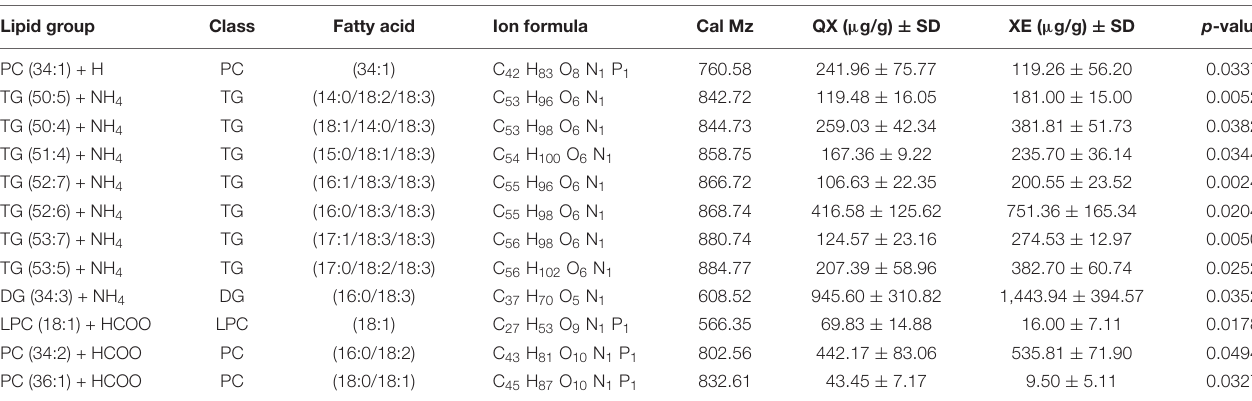
FIGURE 3 | Analysis of differential lipid molecules in walnut seed kernels. (A) Volcano plot. The dots represent lipid molecules, among which the blue and red dots are differential lipid molecules that satisfies FC < 0.5, FC > 2, and p < 0.05. (B) Hierarchical and clustering analysis. TABLE 1 | Lipid molecules showing significant differences between two walnut varieties ( p < 0.05).